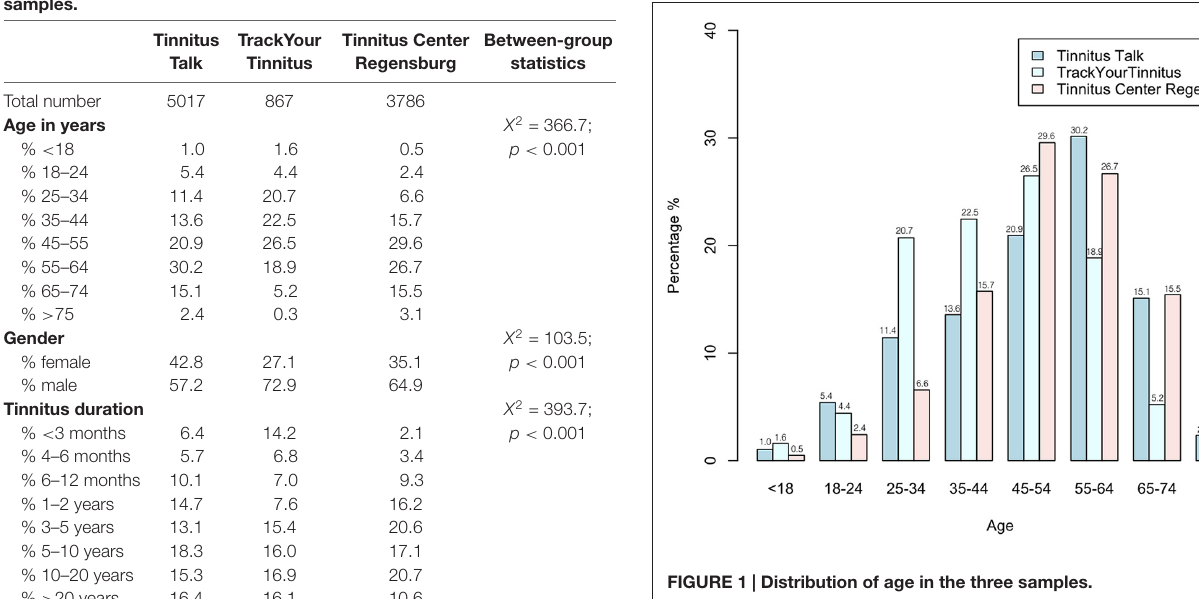
FIGURE 1 | Distribution of age in the three